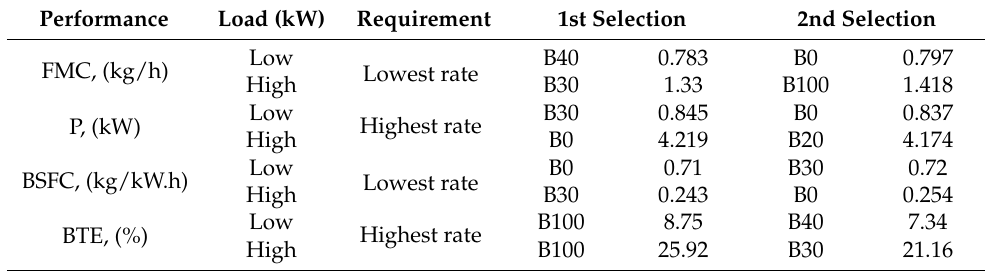
Table 4. Recapitulation of fuel selection considering the performance test